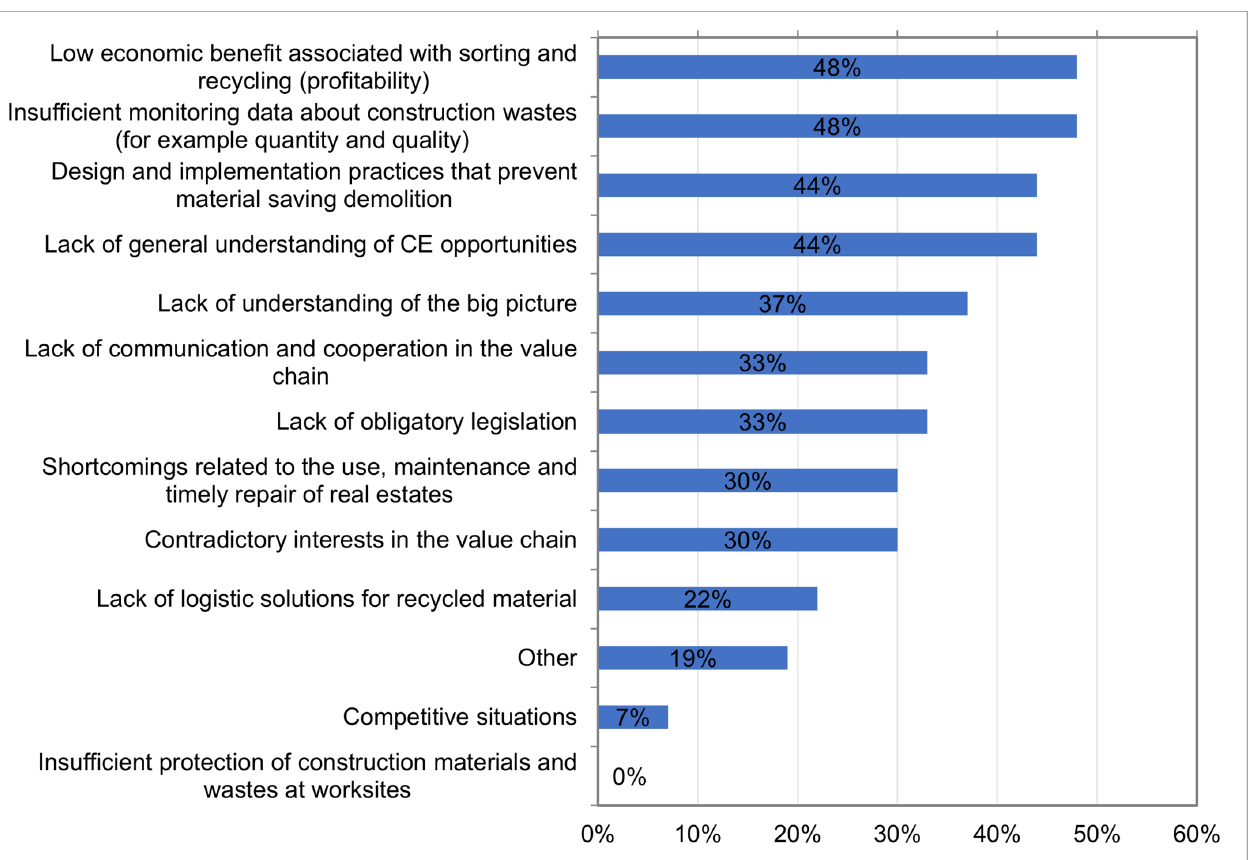
Figure 3. Most important barriers to circular economy in the construction sector.